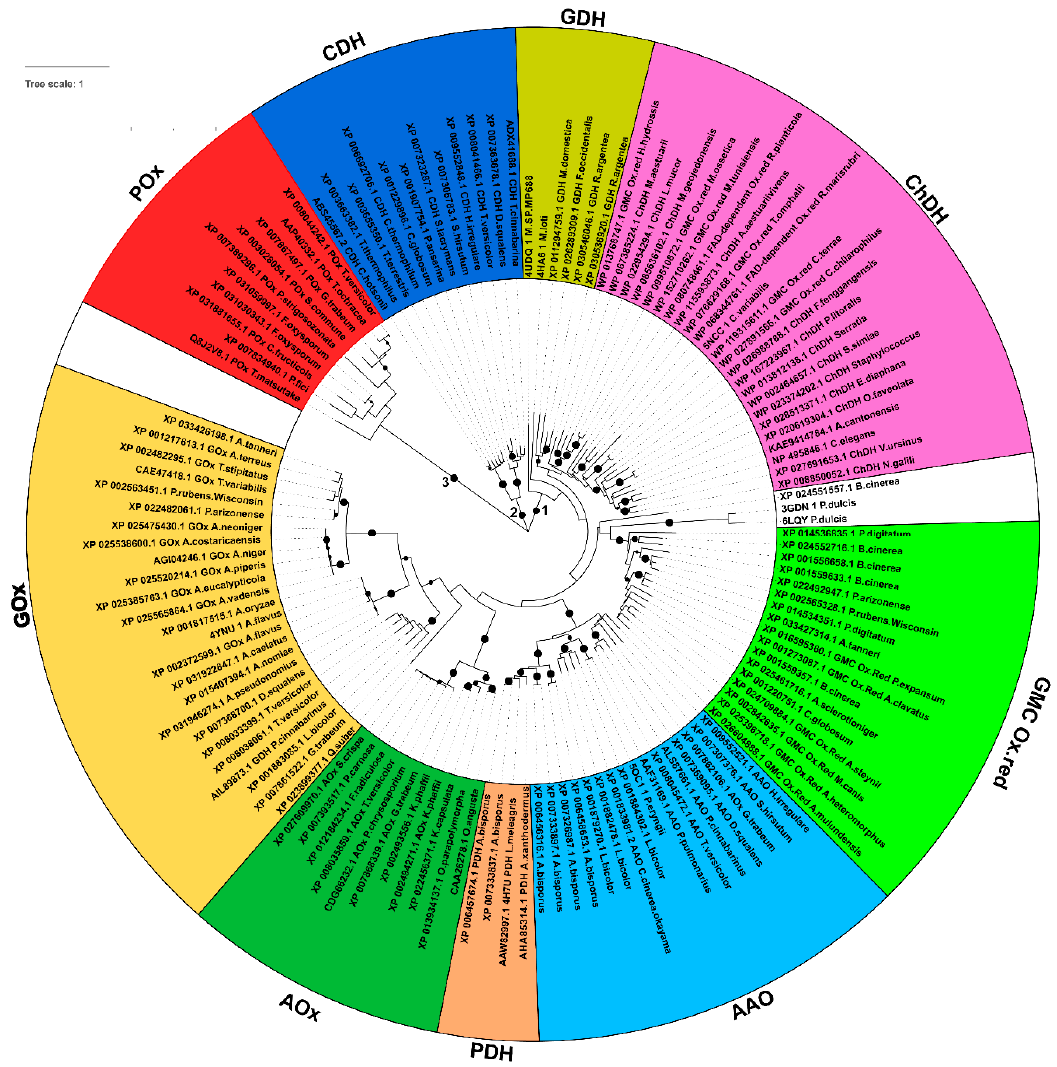
Figure 1. Phylogenetic tree of the sampled GMC oxidoreductase sequences. Maximum likelihood phylogenetic tree of GMC oxidoreductase protein sequences selected from representative taxonomic groups of Fungi (with specific attention to Botrytis, Aspergillus , and Penicillium species among the others), Plants , Metazoa, and Bacteria . Sequence names are reported in correspondence of each leaf, according to the assigned names retrievable together with fasta sequences along blastp searches. Bootstrap values greater than 80% are reported in correspondence of the interested nodes as black circles. The three main subgroups reported in the tree are indicated by numbers “1–3”. Cluster of sequences are grouped and colored based on the sequence relationships highlighted by the phylogenetic analyses. The three sequences on the white background, two sequences about lyases (crystallized in complex with FAD) and one B. cinerea sequence are sequence/structurally related to the sampled fungal P. expansum related GMC Ox.red sequences, although phylogenetically distant from the other analysed sequences. Abbreviations: AOx, alcohol oxidases; AAO, aryl-alcohol oxidases; CDH, cellobiose dehydrogenases; GDH, glucose dehydrogenases, GOx, glucose oxidases; PDH, pyranose dehydrogenases; POx, pyranose oxidases; GMC Ox.red, P. expansum related GMC oxidoreductases; ChDH, choline dehydrogenase.